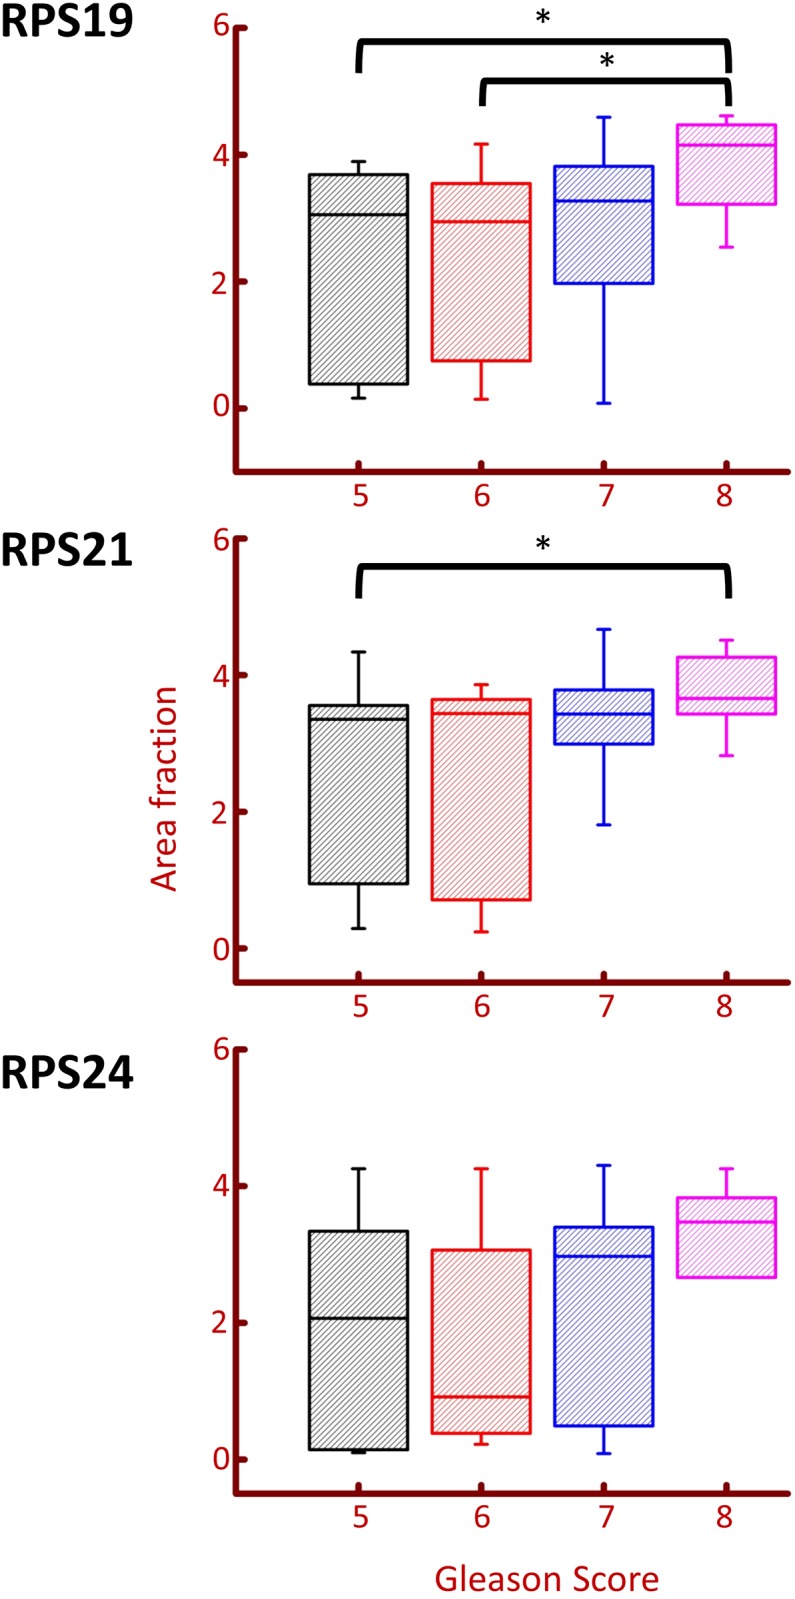
Changes in RPS protein expression with Gleason grade.Box plots were created in Origin software to show the changes in expression of RPS19, RPS21, and RPS24, in different Gleason grades. Brackets represent significant differences in protein expression (p<0.05). A significant change was observed between RPS19 Gleason grades 5 and 8, and 6 and 8 (p = 0.007 and p = 0.028 respectively). A significant difference was also observed in RPS21 Gleason grades 5 and 8 (p = 0.0488).